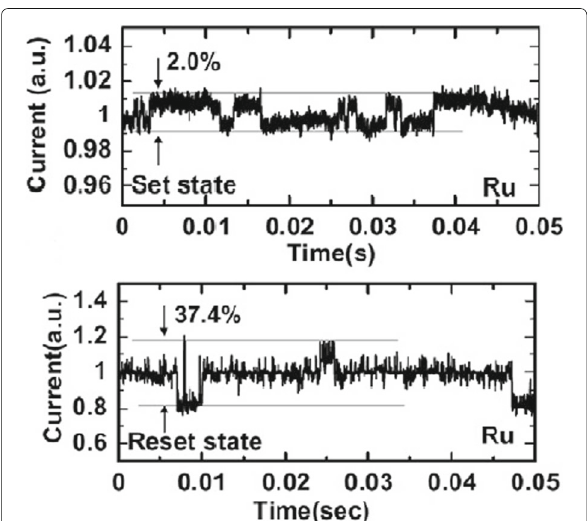
Fig. 10 Complex RTN signals in LRS and HRS of Ta 2 O 5 /TiO 2 -based RRAM depicting normalized noise amplitude and average current; reprinted from ref.